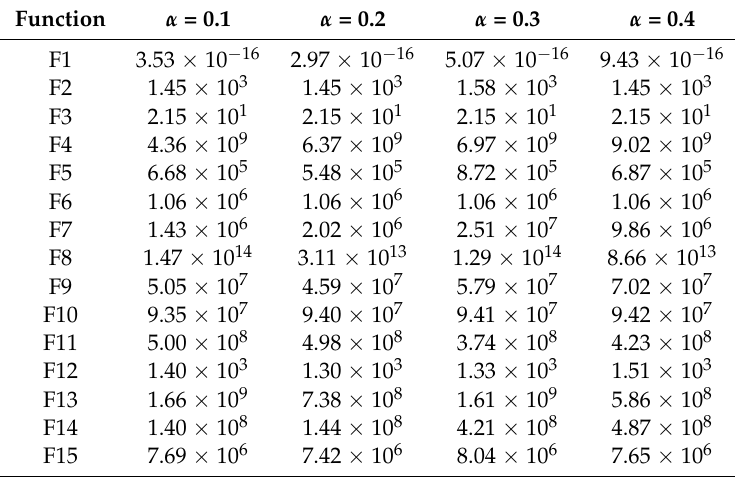
Table 2. The different values of α to EA-PSO’s performances on IEEE CEC 2013 large scale optimization problems with 1000 dimensions (fitness evaluations = 3 × 10 6